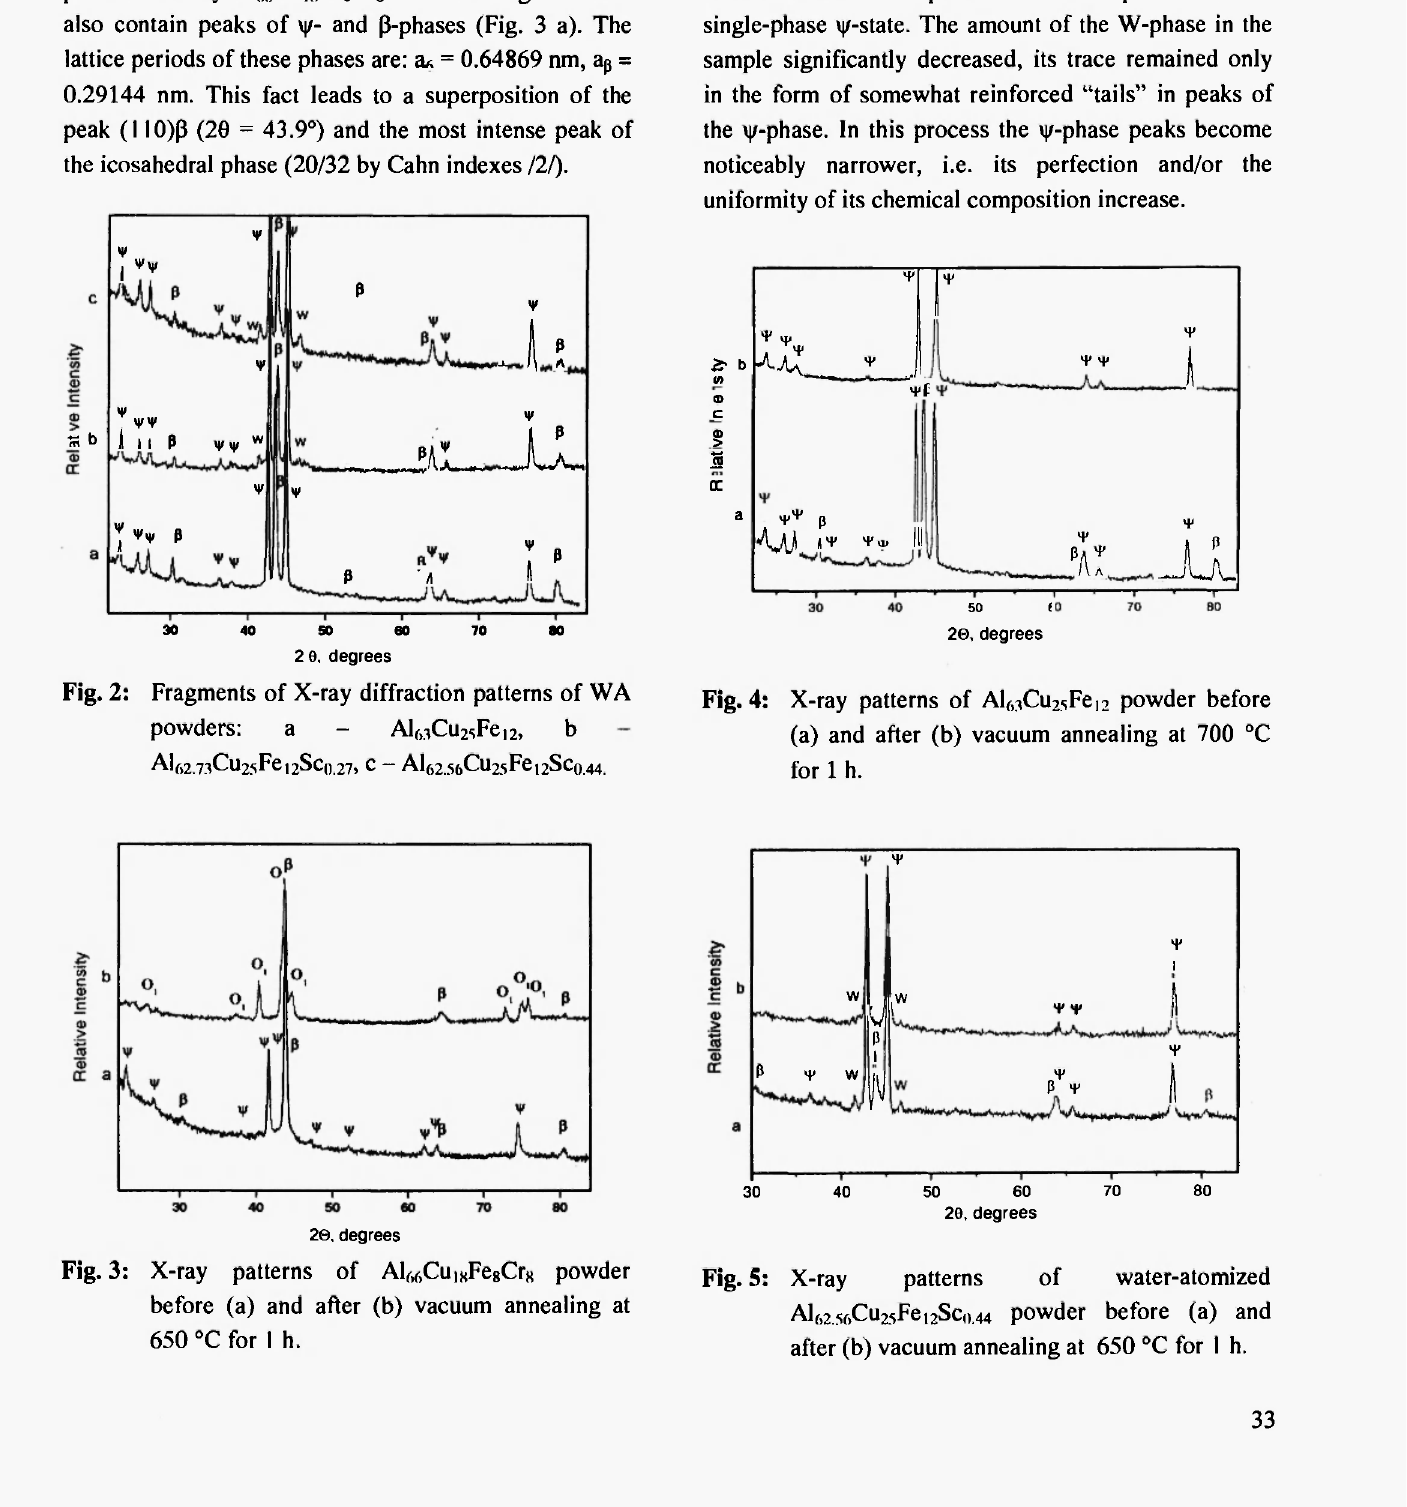
Fig. 2: Fragments of X-ray diffraction patterns of WA powders: Alft2.73CU25Fe12SC0.27, C - Alft2.5ftCU25Fe12SC0 .44.